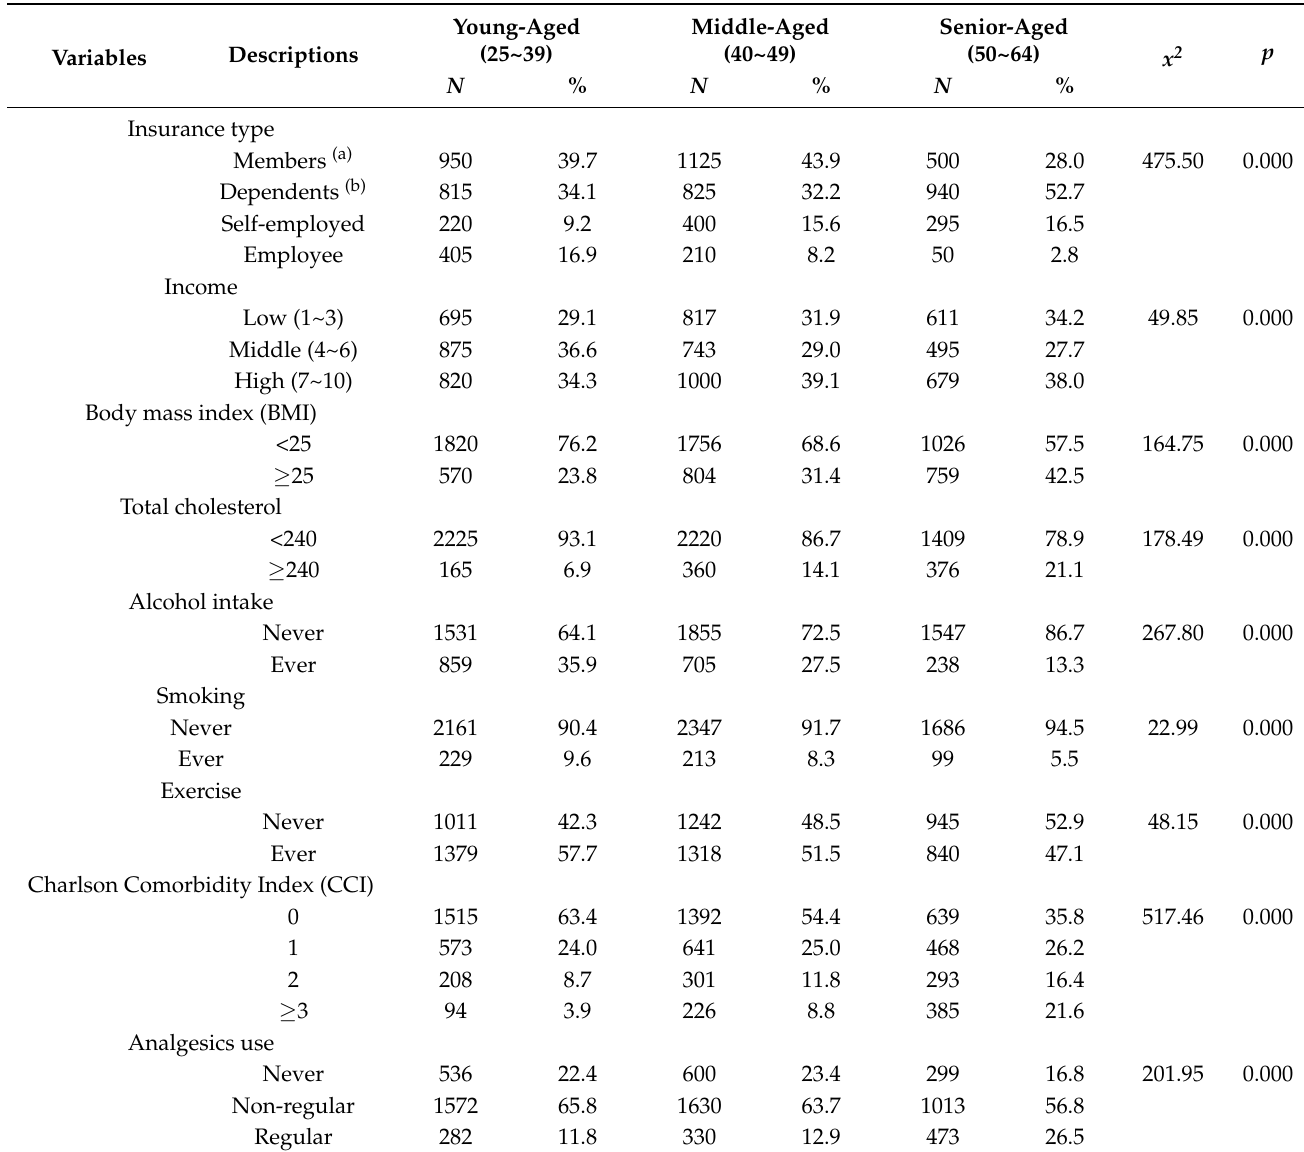
Table 1. Baseline characteristics of the study